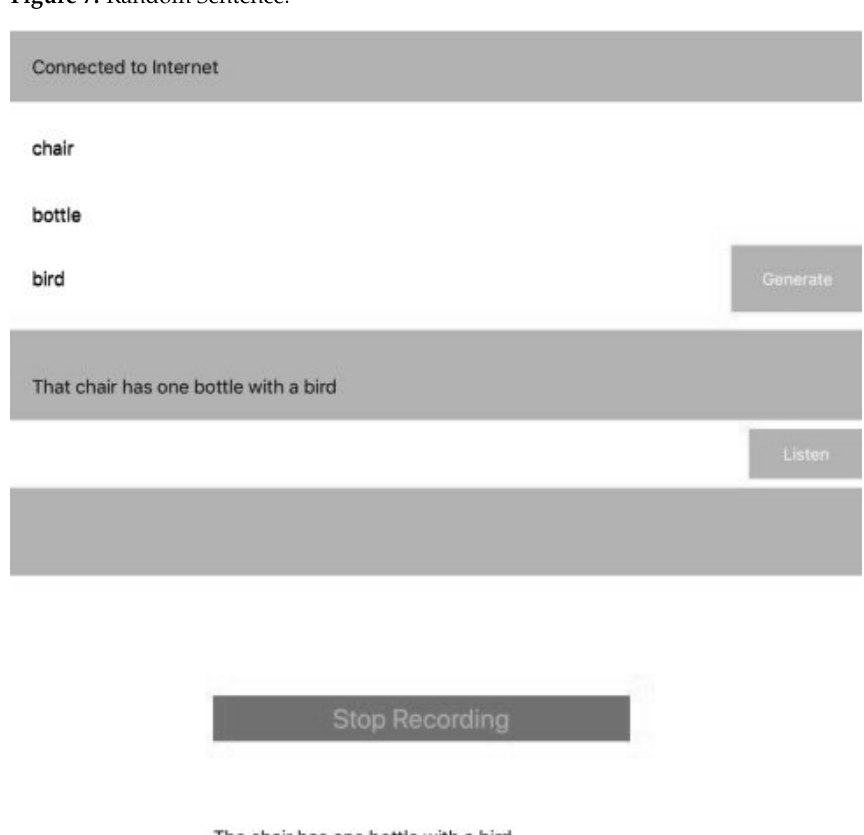
Figure 7. Random Sentence.